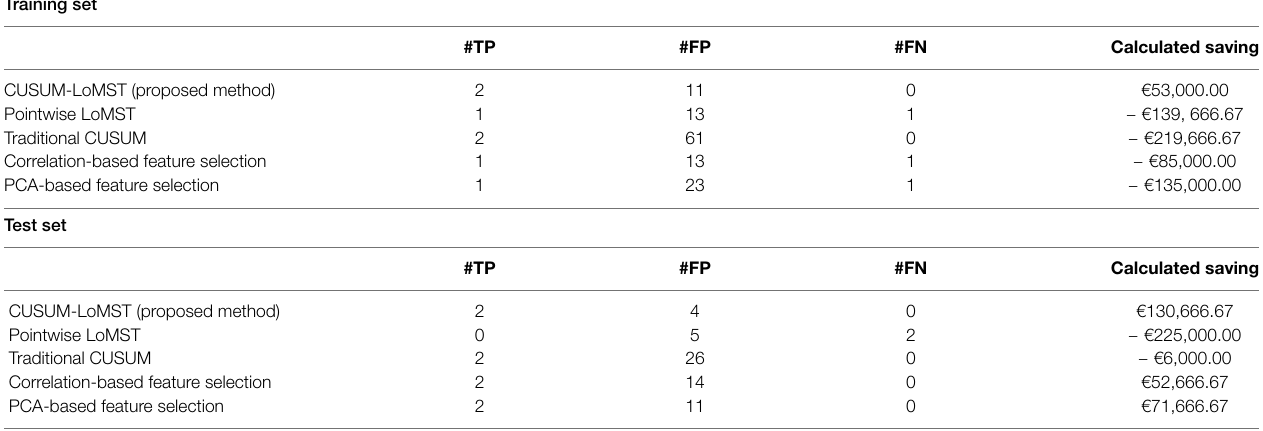
TABLE 4 | Comparison of four alternative methods with the proposed CUSUM-LoMST. Training